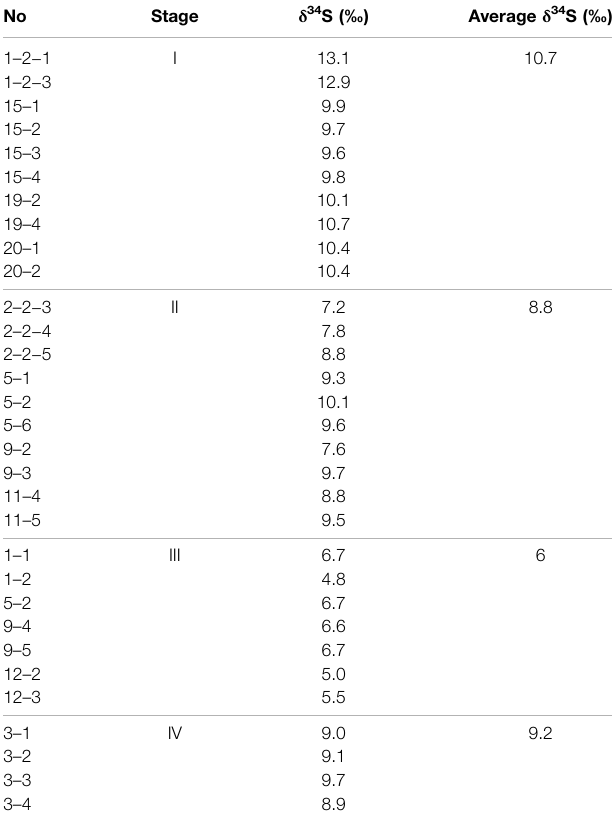
TABLE 4| Pyrite δ 34 Svalues ofdifferenthydrothermalstagesintheZhaoxian gold deposit. No